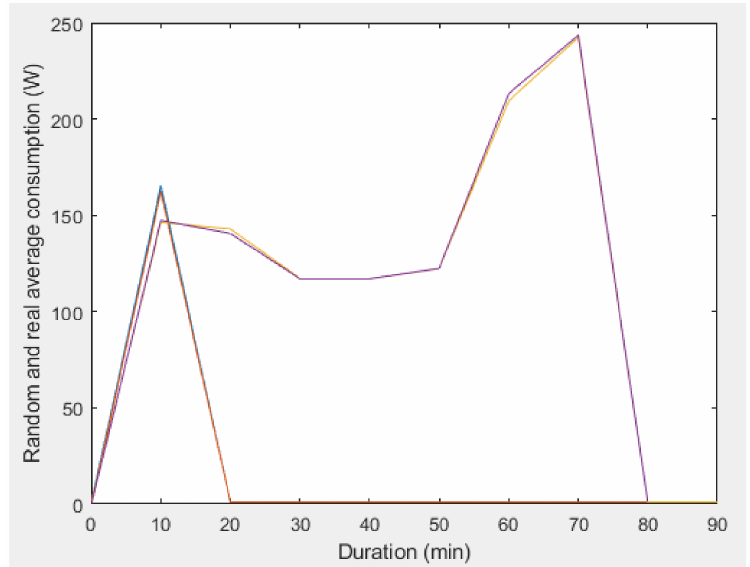
Figure 14. Random (blue and yellow) and real (orange and purple) averages consumption of the washing machine, whose durations are 10 and 70 min during working days.